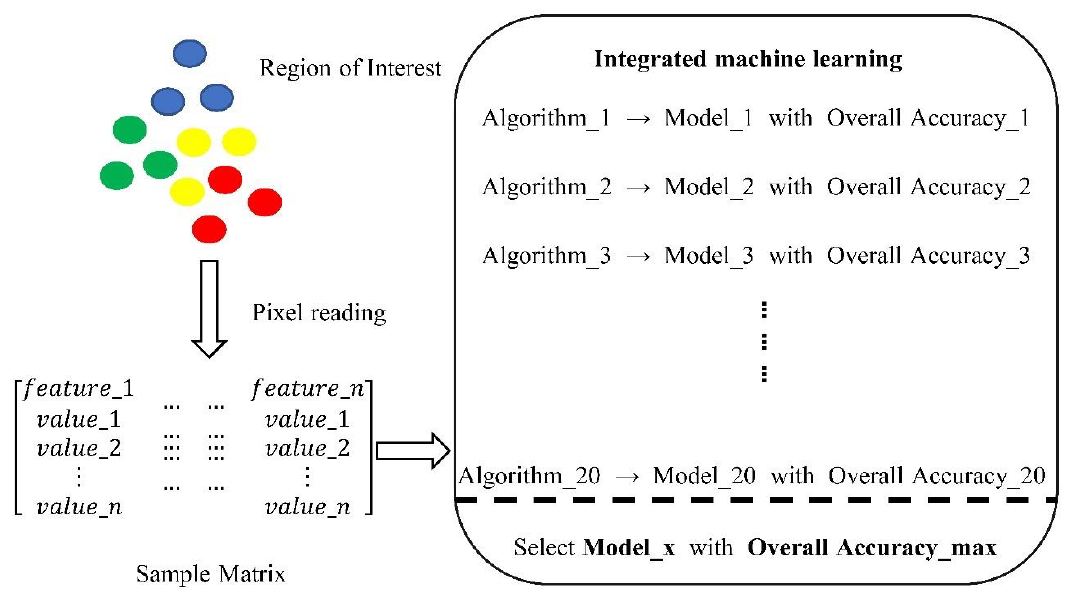
Figure 4. Illustration of the integrated machine learning classification method. Different colored circles represent samples of various land surface types.